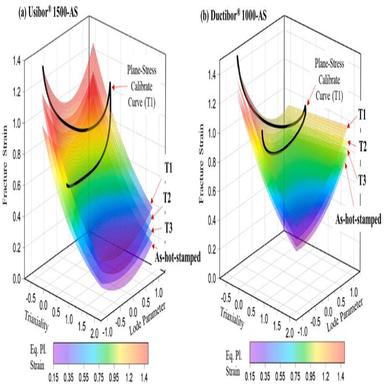
3D Bai-Wierzbicki fracture loci calculated from the 2D plane stress fracture loci in (a) as-hot-stamped Usibor® 1500-AS, and (b) ashot-stamped Ductibor® 1000-AS. The plane stress loci corresponding to the T1 material condition are also plotted for each alloy (solid curves).